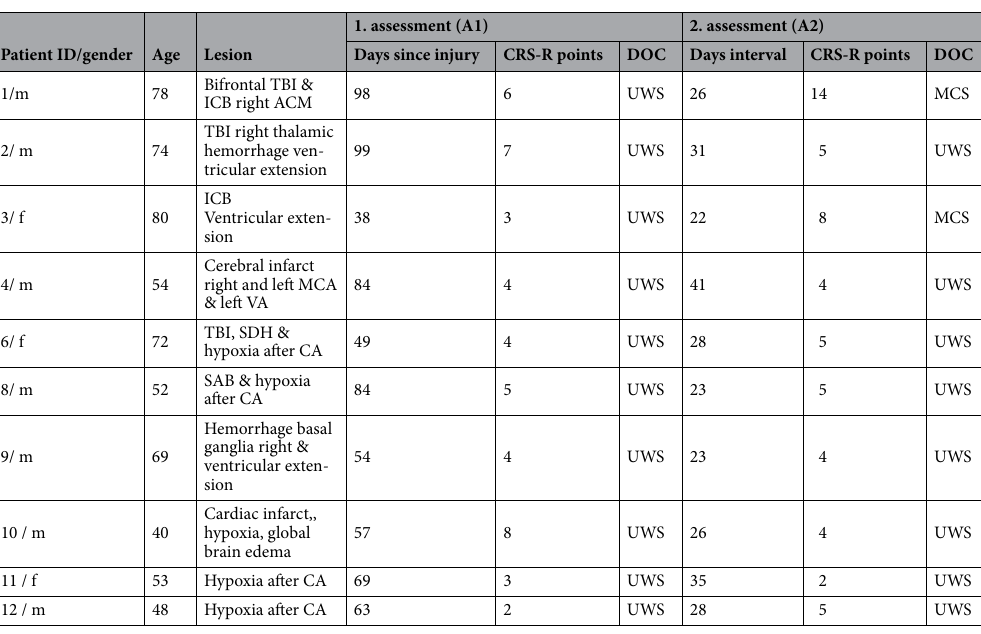
Table 3. Patient characteristics. CRS-R coma recovery scale revised, DOC disorder of consciousness, UWS unresponsive wakefulness syndrome, MCS minimally conscious syndrome, CA cardiac arrest, ICB intracerebral bleeding, SDH subdural hemorrhage, SAB subarachnoid bleeding, TBI traumatic brain injury, MCA medial cerebral artery, VA vertebral